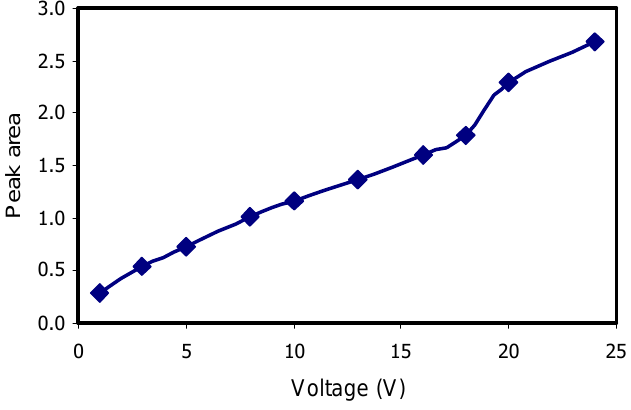
(the circuit of V ) C C